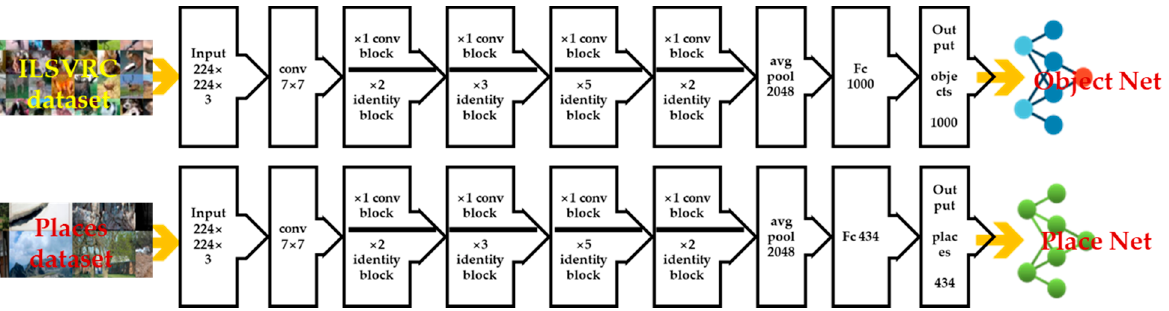
Figure 3. Pretrained deep networks models.